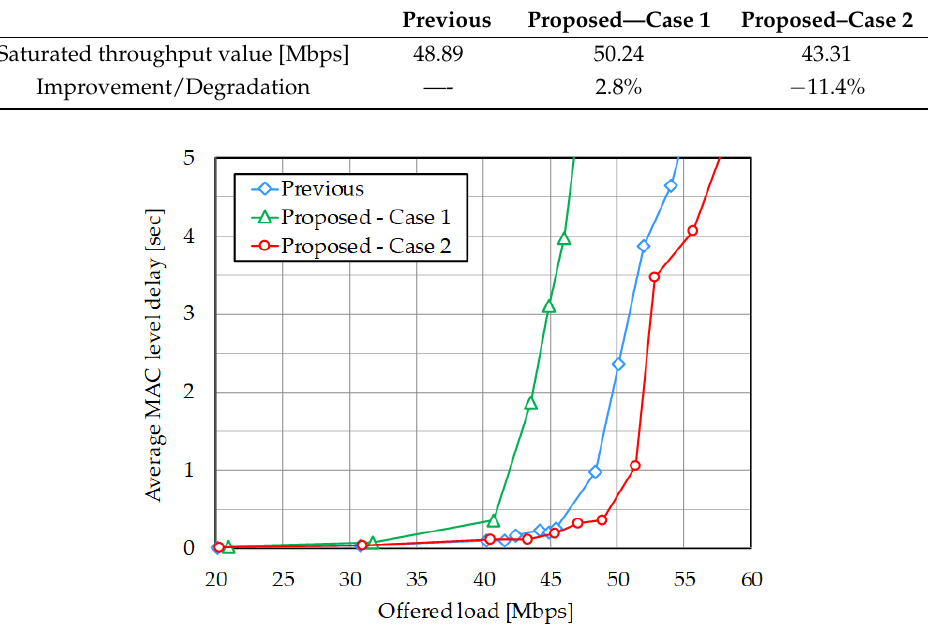
Figure 10. Average MAC level delay in practical